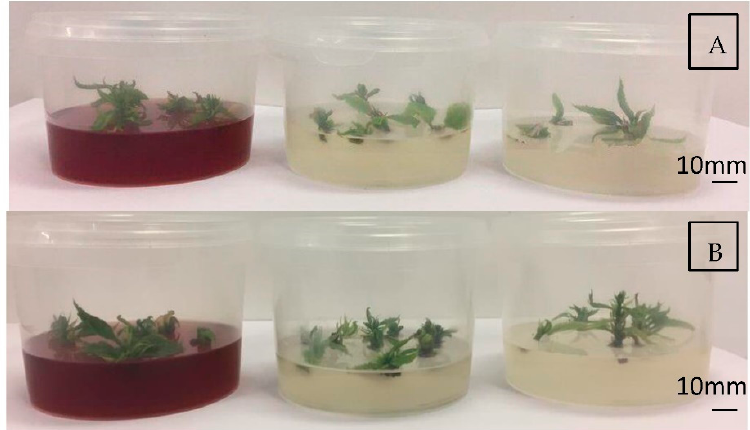
Figure 6. ( A ) In vitro shoots of ‘Marrone di Castel del Rio’ during multiplication in DKW, GD and MS3B media (from left to right). ( B ) In vitro shoots of ‘Garrone Rosso’ during multiplication on DKW, GD and MS3B media (from left to right).